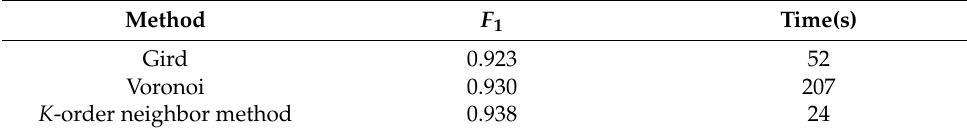
Table 4. Results of different incremental neighborhood judgment